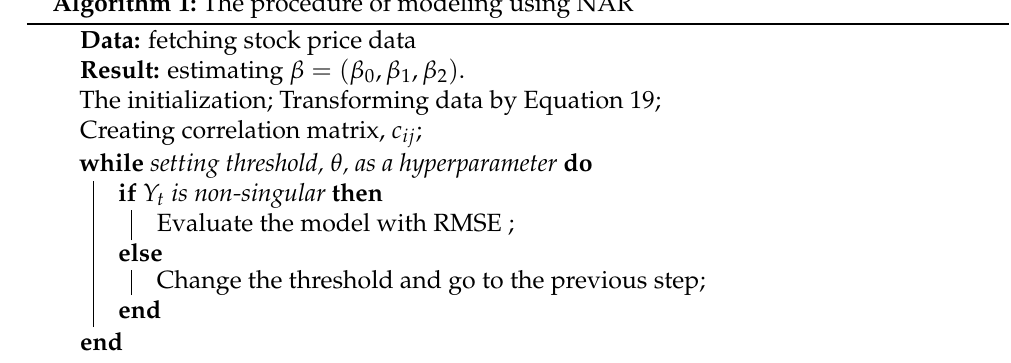
Algorithm 1: The procedure of modeling using NAR